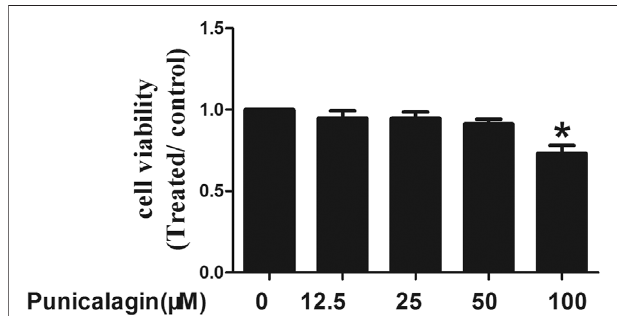
FIGURE 1 | Effects of punicalagin on HUVECs viability. HUVECs were stimulated with punicalagin for 48 h at various concentrations. The control groupwastreatedwithDMSO.CellviabilitywasdeterminedusingMTTassay. This result was repeated in triplicate. * p < 0.05 vs. control group.